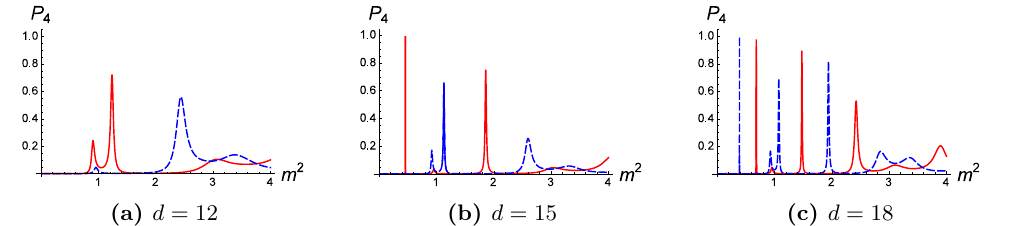
Figure 12. The relative probability P 4 ( m 2 ) of the even parity mode t e ( z ) (red solid lines) and the odd parity mode t o ( z ) (blue dashed lines) quasi-localized between the sub-branes for di(cid:11)erent values of the distance d . The parameter k is set to k = 1, b = 7, and d = 12 ; 15 ;